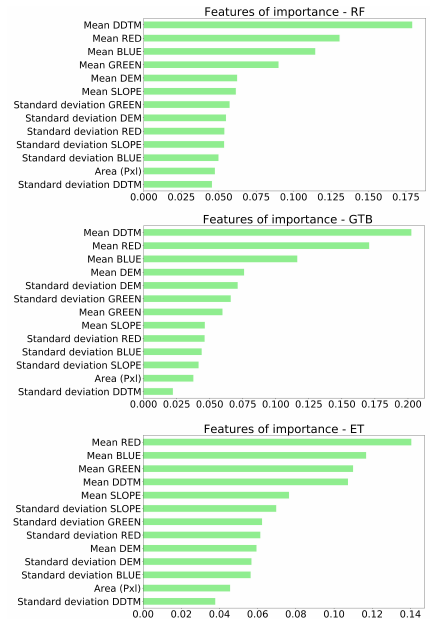
Figure 10. Features of importance for RF, GTB and ET respectively.